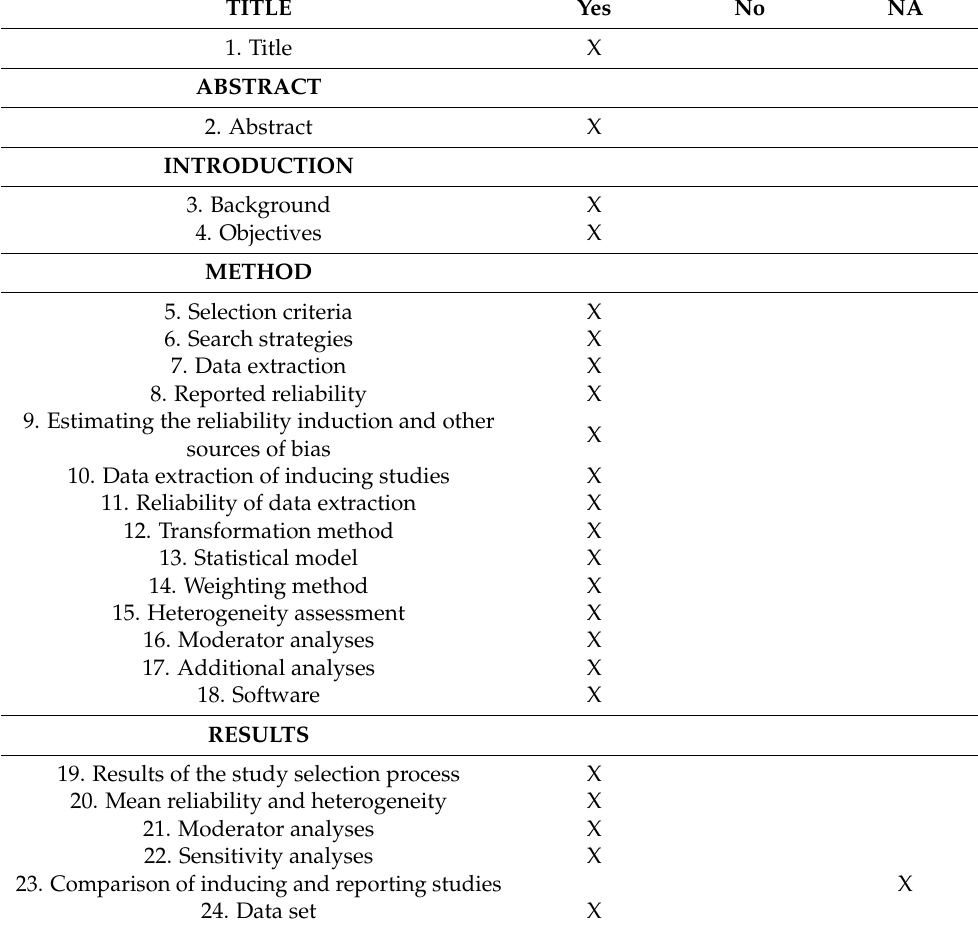
Table A1. Checklist for the corroboration of the meta-analytical report according to the